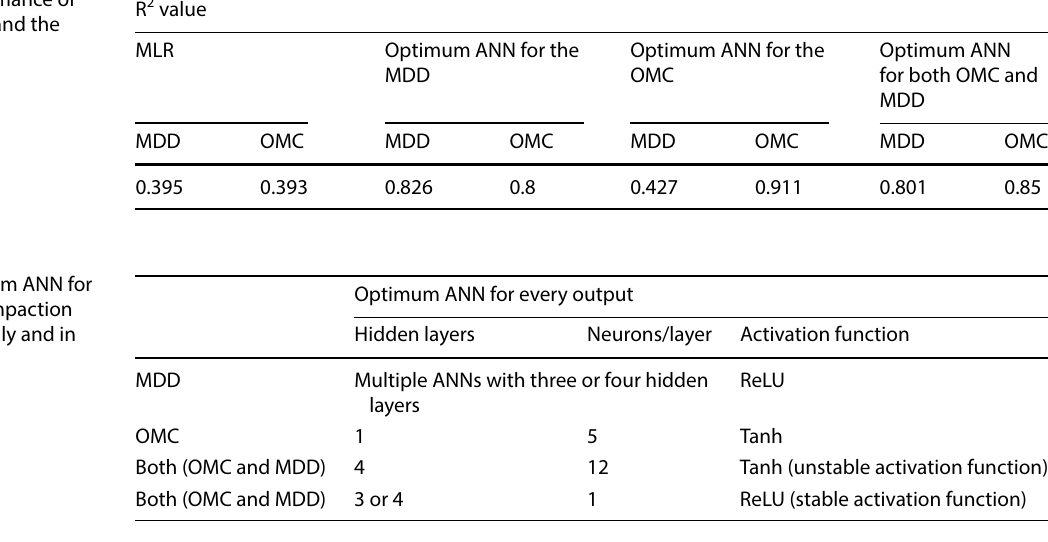
Table 11 The performance of the optimum ANNs and the MLR model